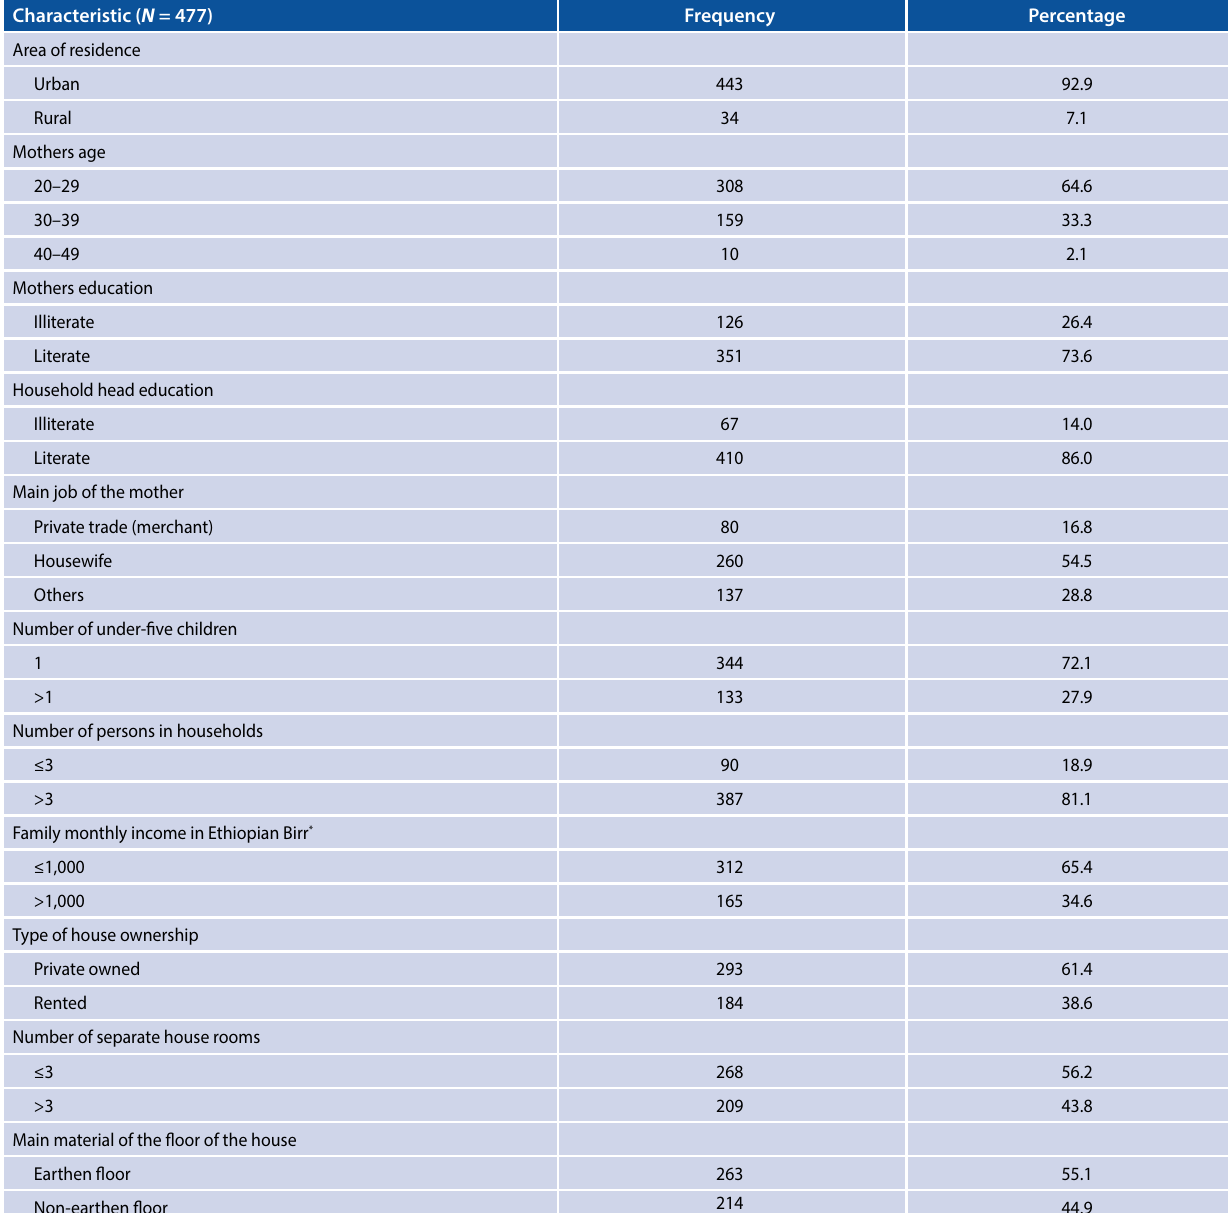
Table 1: Household socio-economic and demographic characteristics ( N =